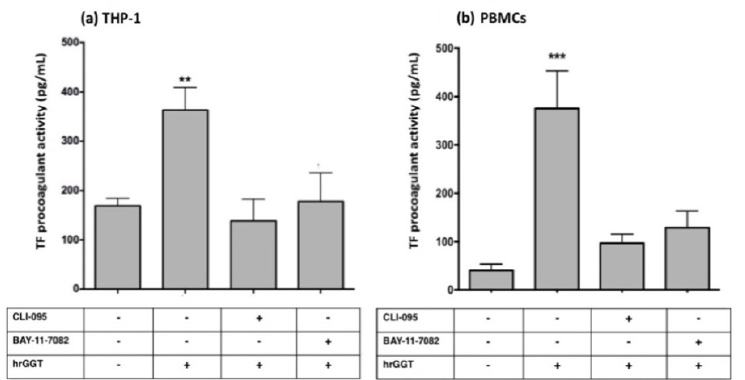
Figure 8. TF procoagulant activities measured in THP-1 ( a ) and PBMCs ( b ). Both cell lines were pre-treated with specific inhibitors (3 × 10 − 6 M CLI-095 and 10 − 5 M BAY-11-7082) for 30 min and subsequently stimulated with hrGGT (1 µ g/mL for 4 h for THP-1 and 0.5 µ g/mL for 18 h for PBMCs). Data are presented as mean ± SEM ( n = 8). ** p < 0.01 vs. the basal condition; *** p < 0.001 vs. the basal condition.